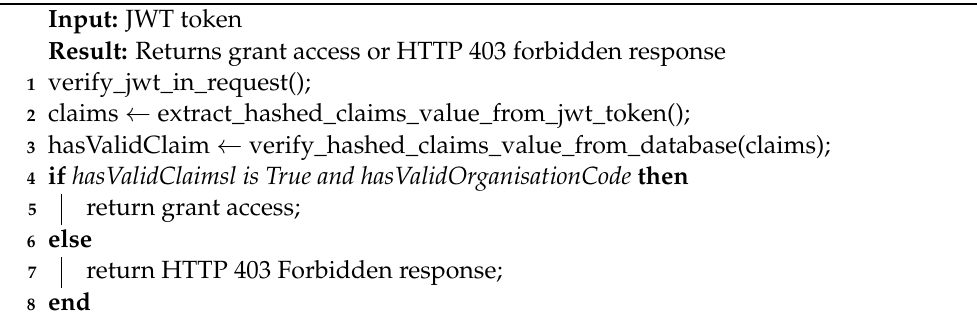
Algorithm 1: Role-based API endpoint access.